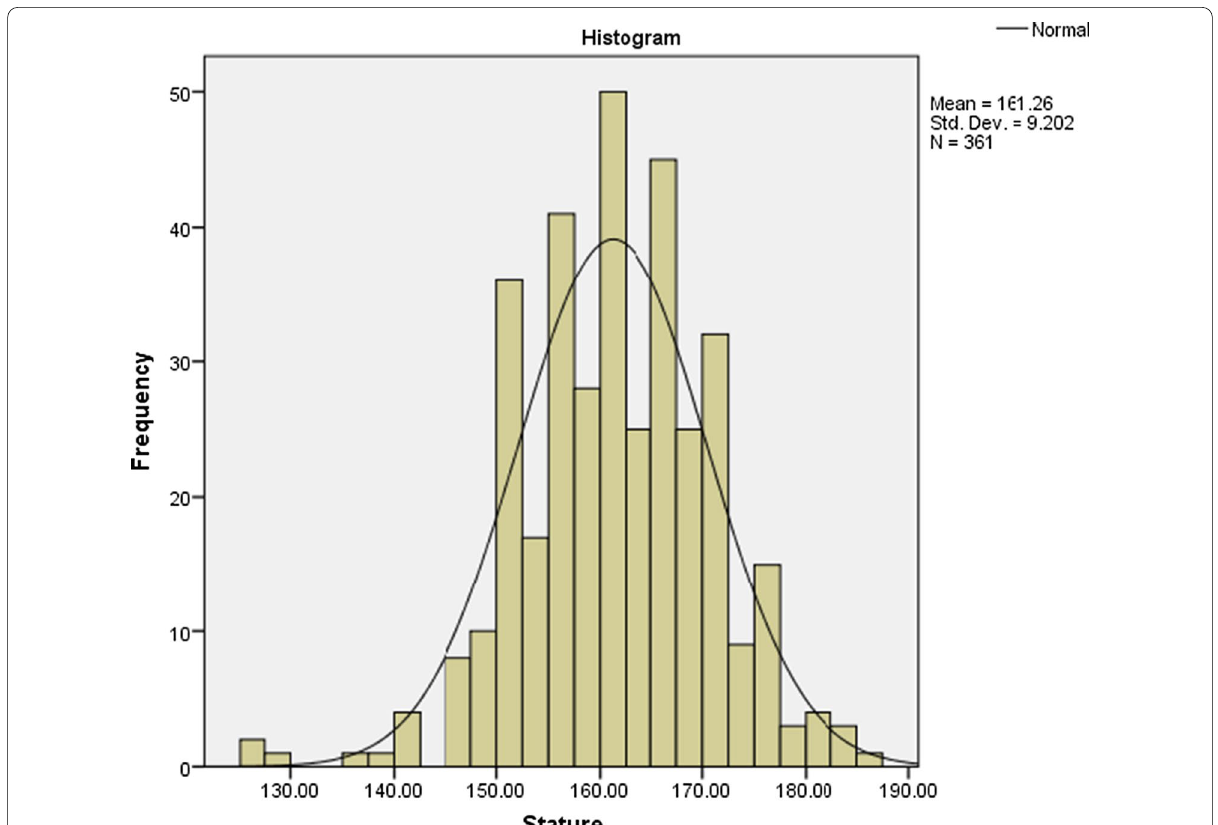
Fig. 4 Histogram for stature distribution of the selected subjects